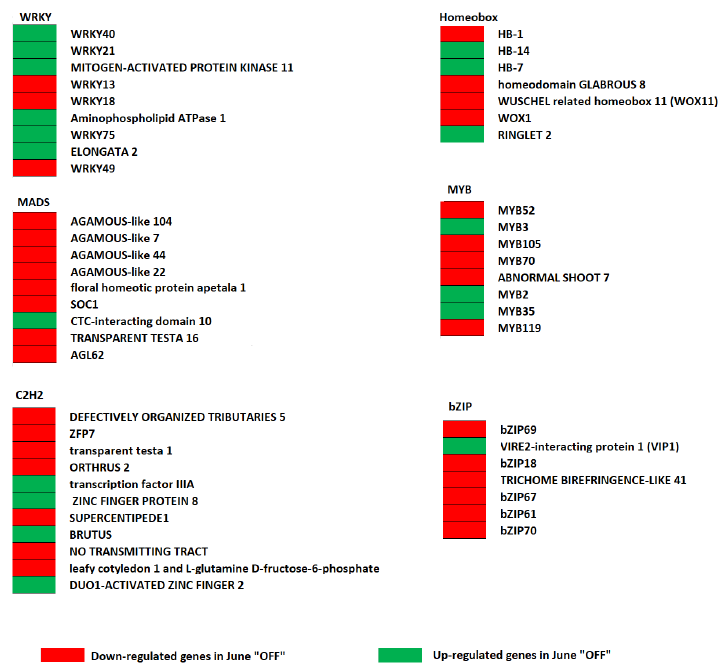
Figure 2. The figure shows transcription factors among the June “OFF” vs . June “ON” fruit s com- parison. Red and green represents down-regulated and up- regulated genes in June “OFF” , respec- Red and green represents down-regulated and up-regulated genes in June “OFF”, tively.